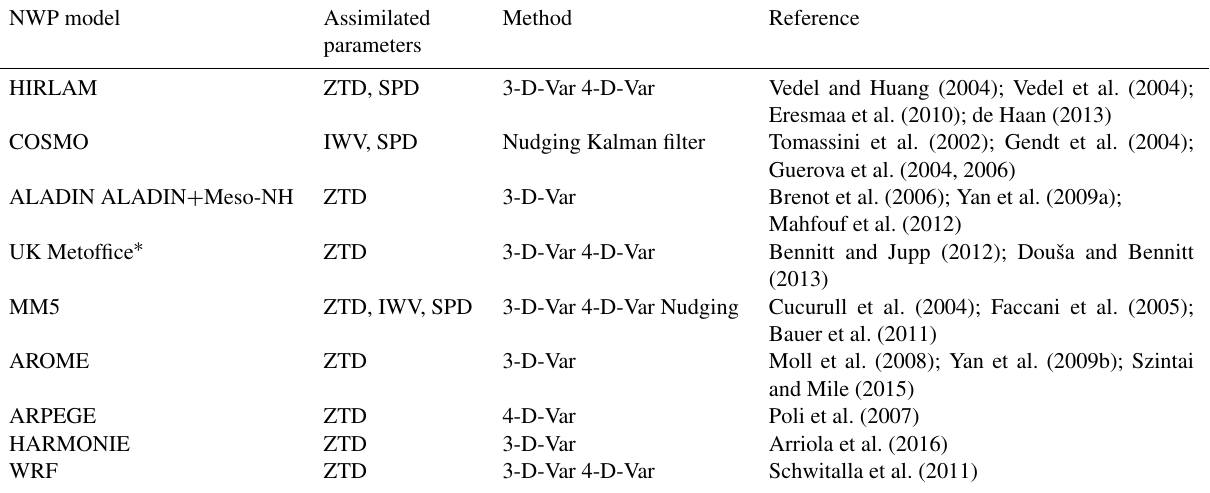
Table 5. Assimilation of GNSS tropospheric products in NWP